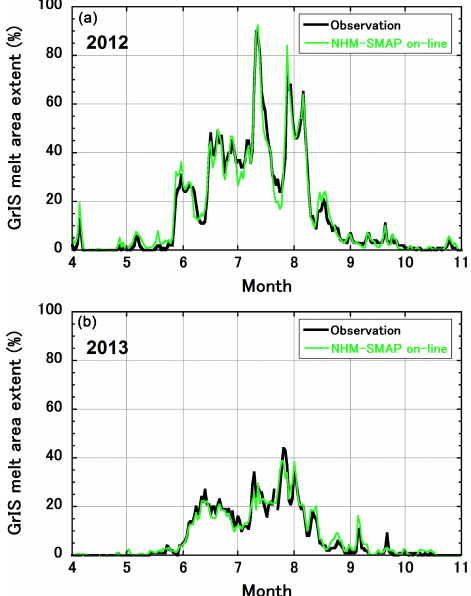
Figure 7. Time series of observed and simulated daily GrIS melt area extent for (a) 2012 and (b) 2013. Observation data are from Mote